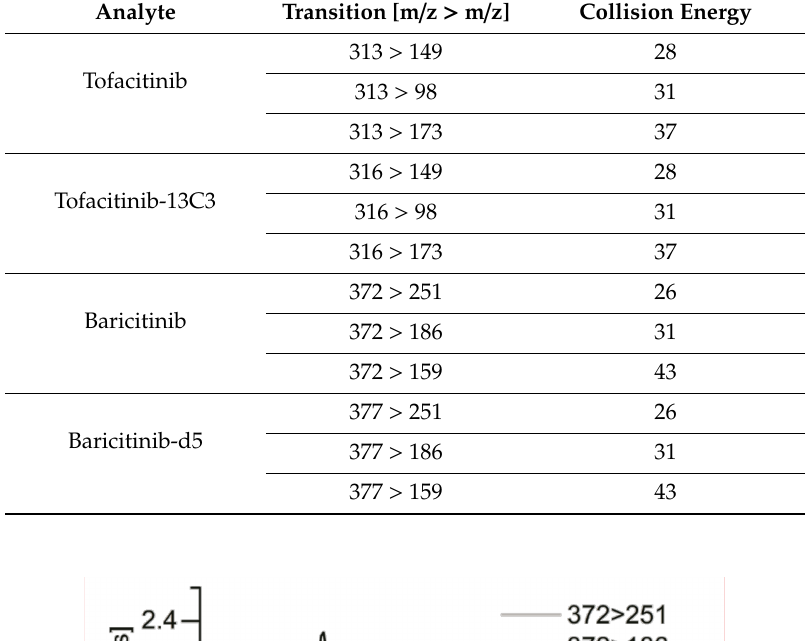
Table 1. MRM transitions of Baricitinib, Tofacitinib, IS and collision energy. The grey-marked fragments had the highest measurement intensity and were used for quantification.